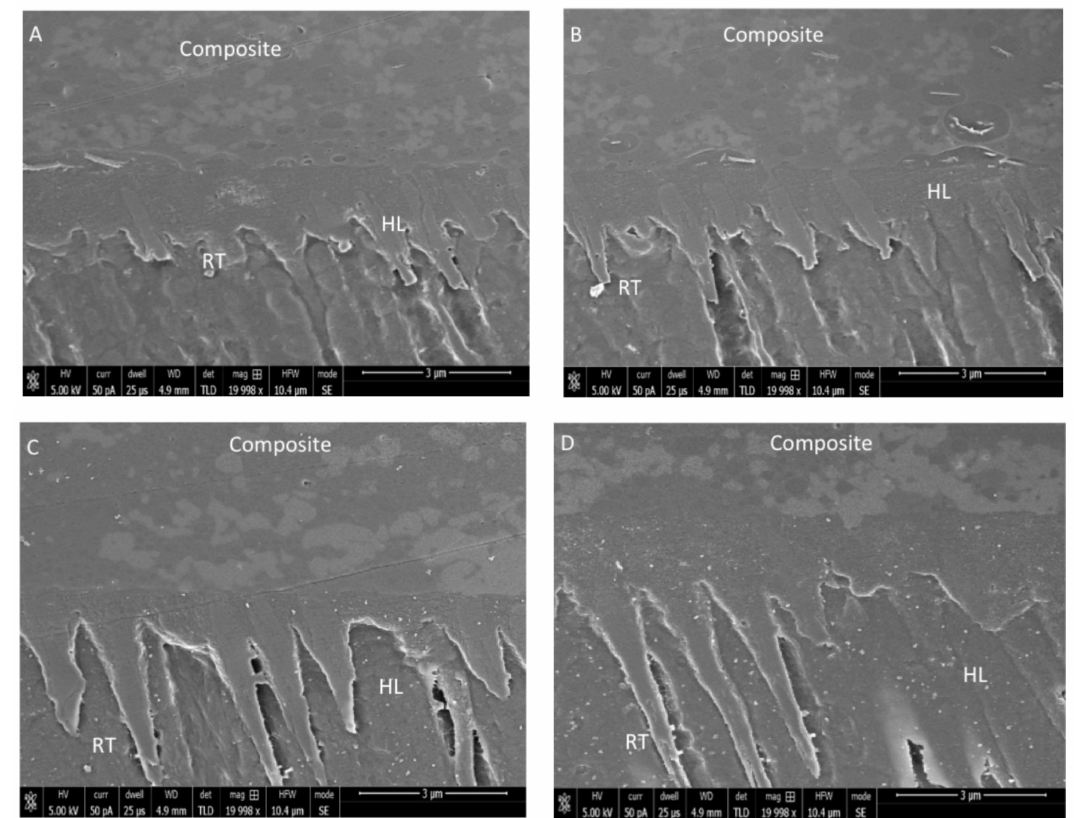
Figure 2. Resin–dentin-bonded samples using ( A ) unfilled adhesive (Si-EA-0%), ( B ) 5% silica-filled adhesive (Si-EA-5%), ( C ) 10% silica-filled adhesive (Si-EA-10%) and ( D ) 15% silica-filled adhesive (Si-EA-15%). The silica-filled and unfilled adhesive resins show similar resin tag formation, in contrast to high filler adhesive samples. (HL: hybrid layer, RT: resin